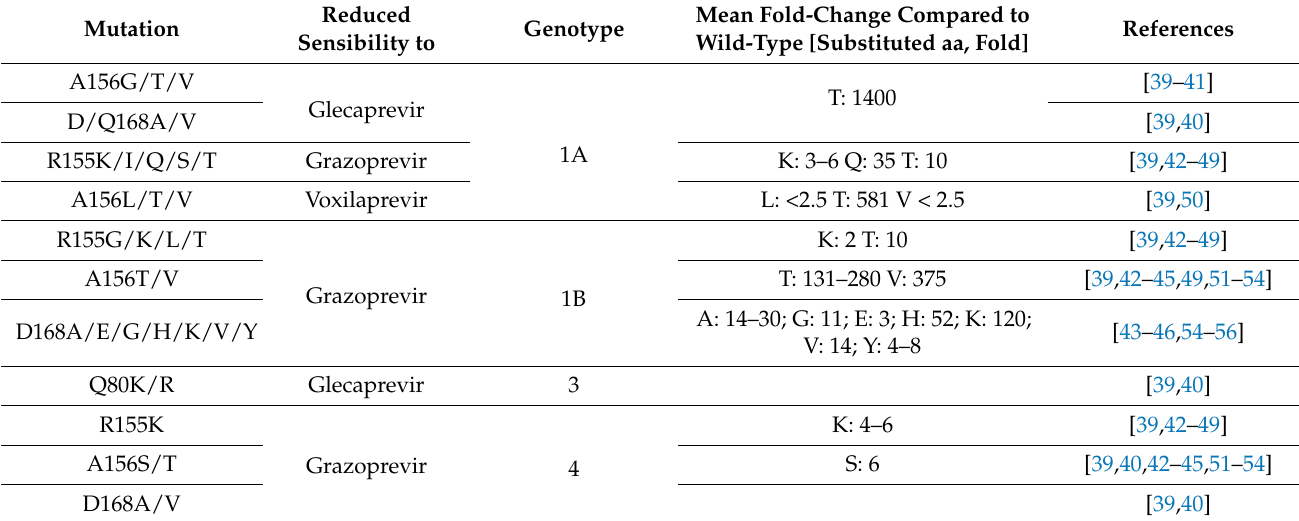
Table 2. RASs in NS3 region with fold-change compared to wild-type replicon according to HCV genotype.